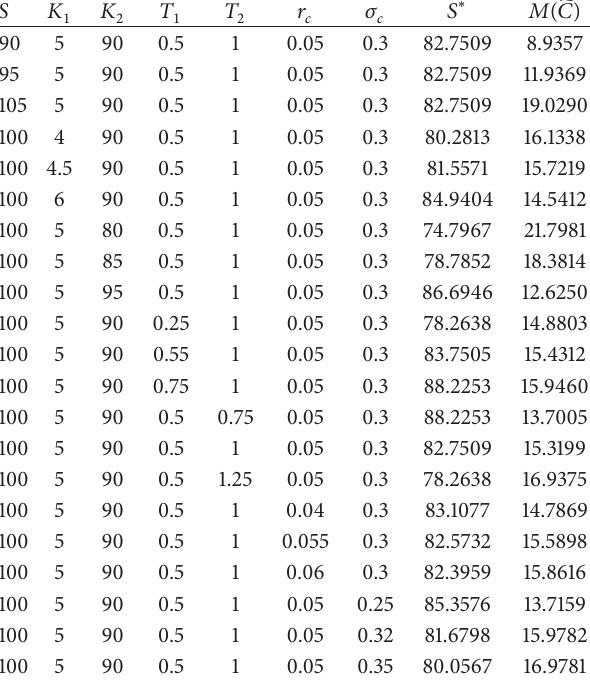
Table 1: The numerical results of 𝑆 ∗ and 𝐶 under Black-Scholes model.